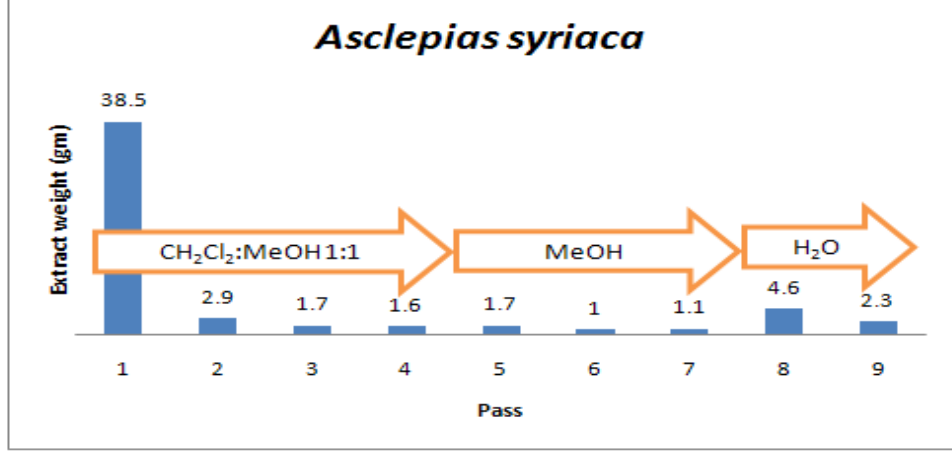
Figure 5. Extractables as a function of the number of solvent passes through a